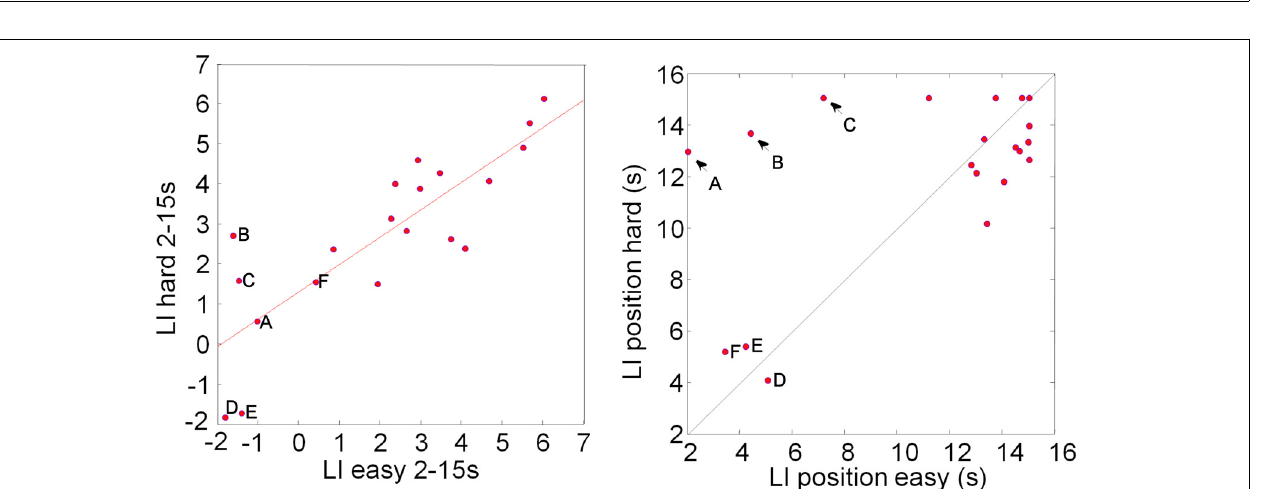
windows that are the basis for the LI analysis: in the majority of cases LIs derive from similar positions between 10 and 15s after task onset; for three individuals (A–C) peak LI values were found toward the end of the hard task conditions, but at the beginning of the “easy” conditions (arrows in right plot); for another three participants LIs were computed for relatively early responses (around 4s) in both tasks. We argue that for a meaningful correlation analysis, matching time windows should be